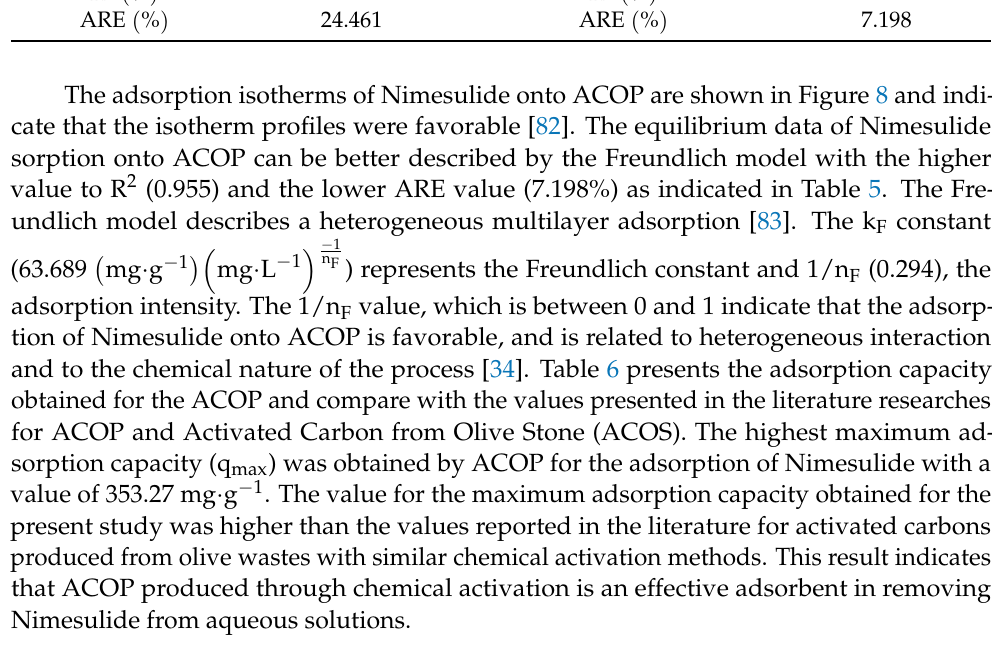
Table 6. Adsorption capacity obtained for the ACOP and literature